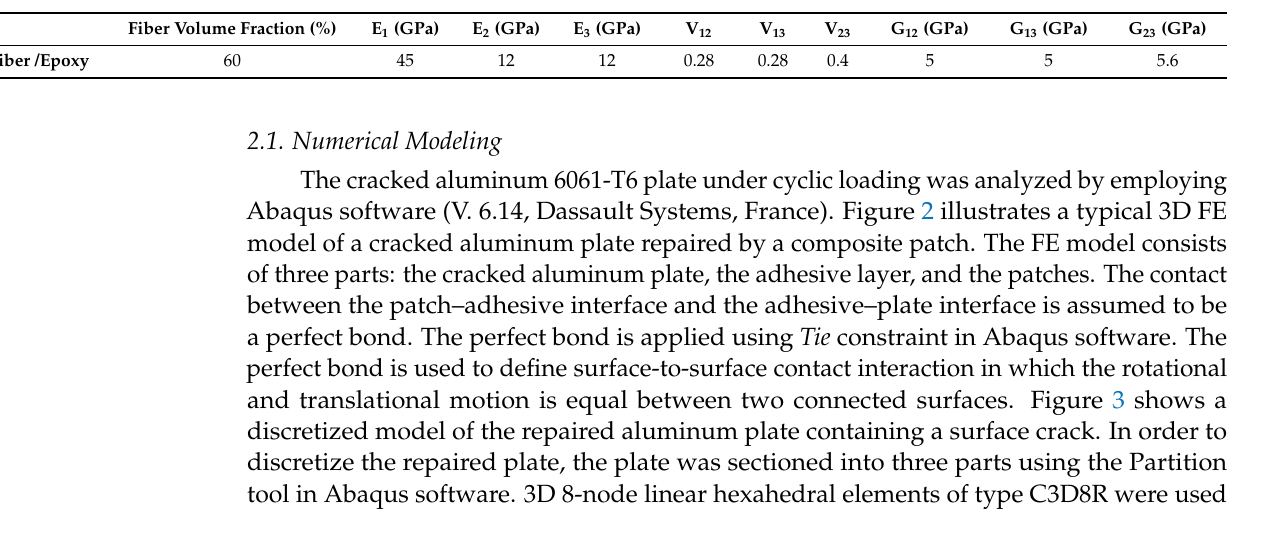
Table 3. Mechanical properties of glass fiber/epoxy composite patch